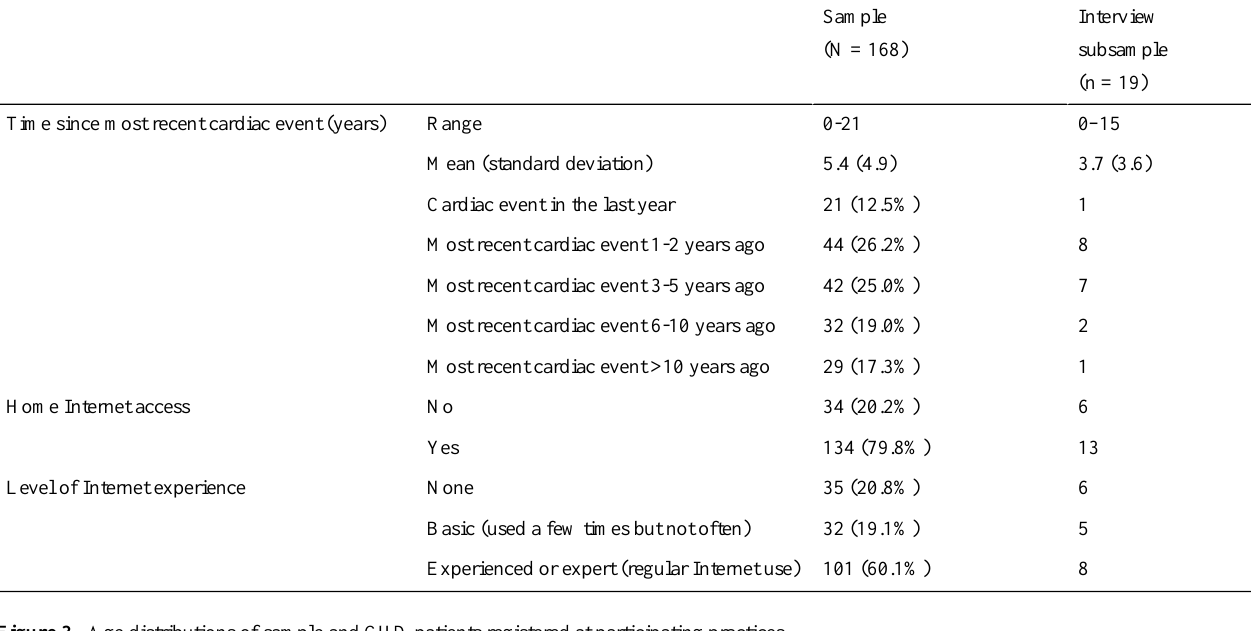
Figure 3. Age distributions of sample and CHD patients registered at participating